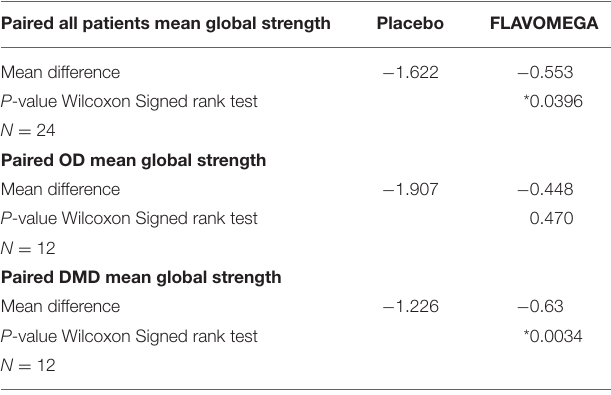
TABLE 8 | FLAVOMEGA effect at T24 weeks on global strength